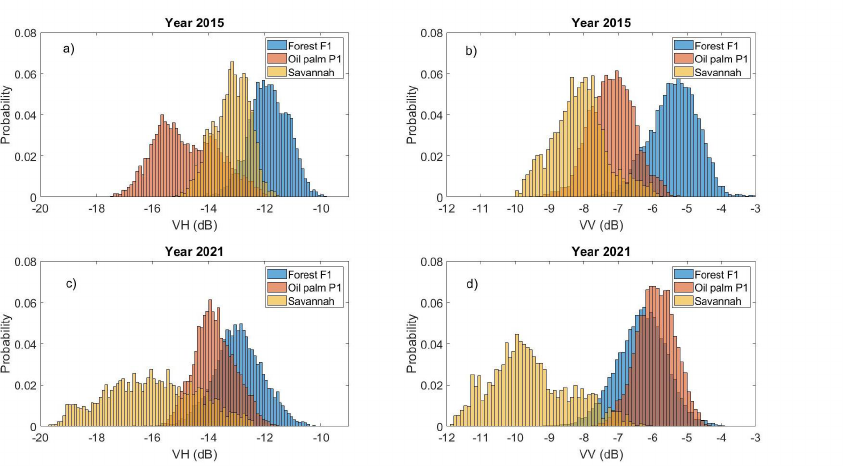
Figure 4. Histograms of backscatter in 2015 and 2021 acquisitions during the wet season for forest (F1), oil palm plantation (P1) and savannah: ( a ) VH in 2015; ( b ) VV in 2015; ( c ) VH in 2021; and ( d ) VV in 2021. Corresponding statistics are given in Figure 5.